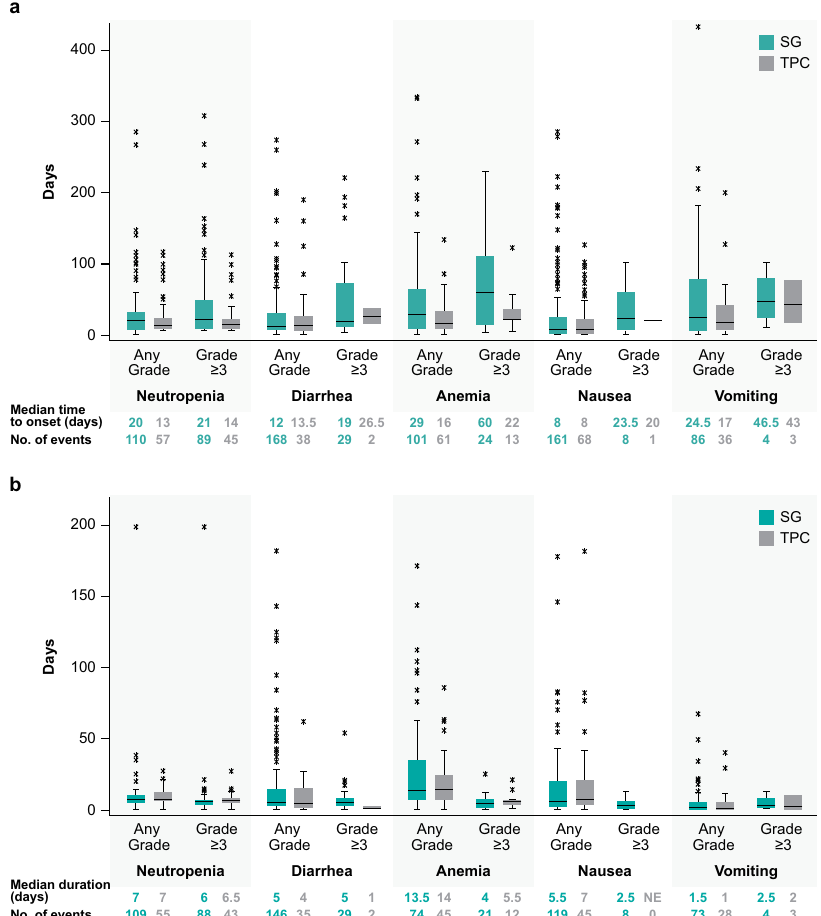
Fig. 1 Time course of treatment-related adverse events of special interest. a Time to onset of fi rst event of treatment-related AESI and ( b ) duration of an individual episode of treatment-related AESI of any grade and grade ≥ 3 in the Safety Population. Box and whisker plots, with upper and lower boundaries of each box plot representing the 25th and 75th percentiles and the horizontal lines within the box representing median values. Whiskers extend to the last observation if it was not an outlier (de fi ned as greater than Q3 + 1.5 × IQR or less than Q1 – 1.5 × IQR) or to the minimum/maximum values if an outlier was not identi fi ed. Outliers are indicated by an asterisk. AESI adverse event of special interest, IQR interquartile range, Q1 fi rst quartile, Q3 third quartile, SG sacituzumab govitecan, TPC treatment of physician ’ s choice.